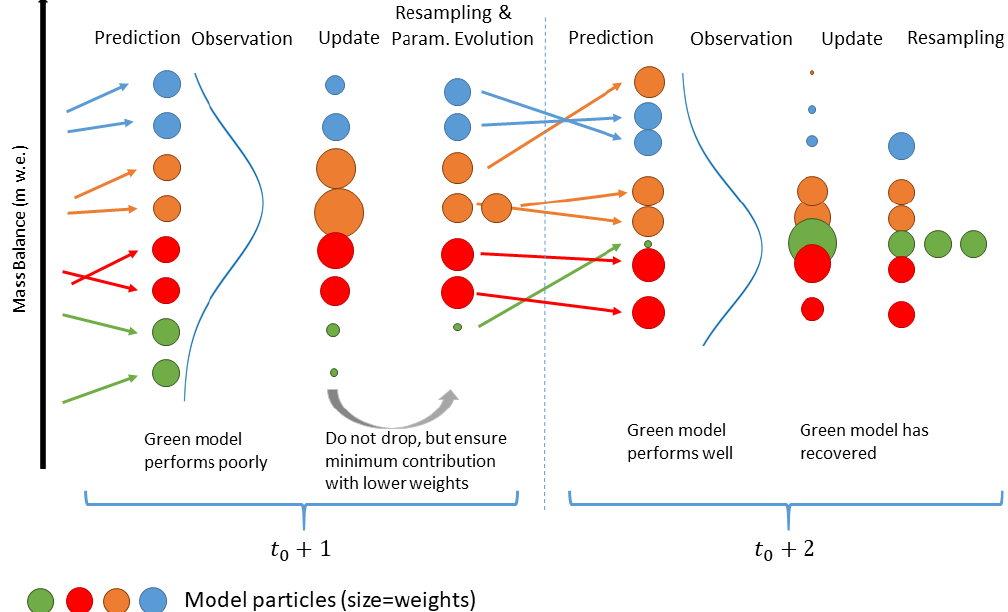
Figure 6. Illustration of the individual particle filter steps. The example refers to a case in which four models (blue, orange, red, and green) start with two particles each. The blue curve represents the observation distribution. At time step t 0 + 1, the green model performs poorly and receives entirely low weights during the update step (weights are shown by the size of the circles). In the resampling step, we modify the weights of the other particles again. This is for not omitting the green model entirely due to temporarily poor performance. As the green model stays in the ensemble, it can recover later, i.e., when making a good prediction (here: t 0 +